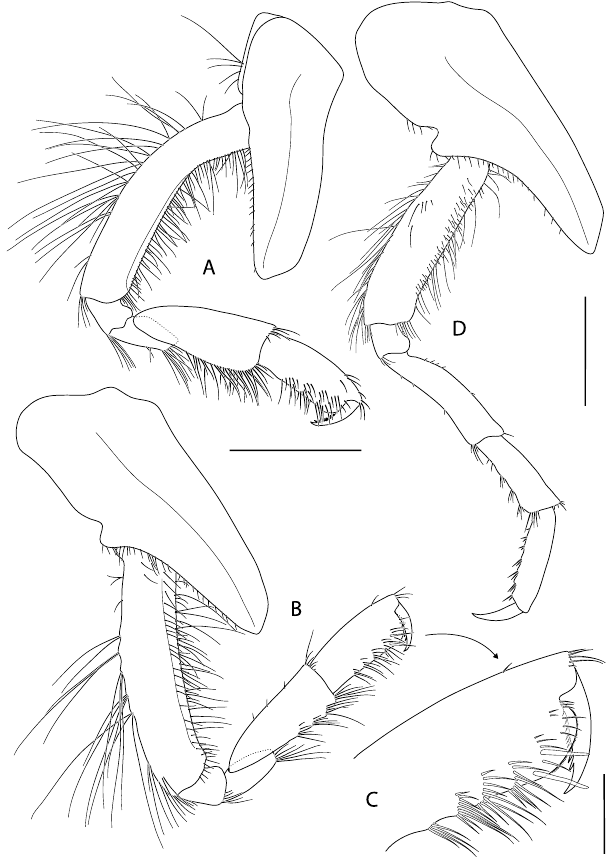
Figure 17. Epimeria cornigera , neotype, adult female, northern North Sea, NHMUK 2015.3268: ( A ) gnathopod 1, ( B ) gnathopod 2, ( C ) distal articles of gnathopod 2, ( D ) pereopod 3; scales: (A,B,D) 1 mm; (C) 0.25